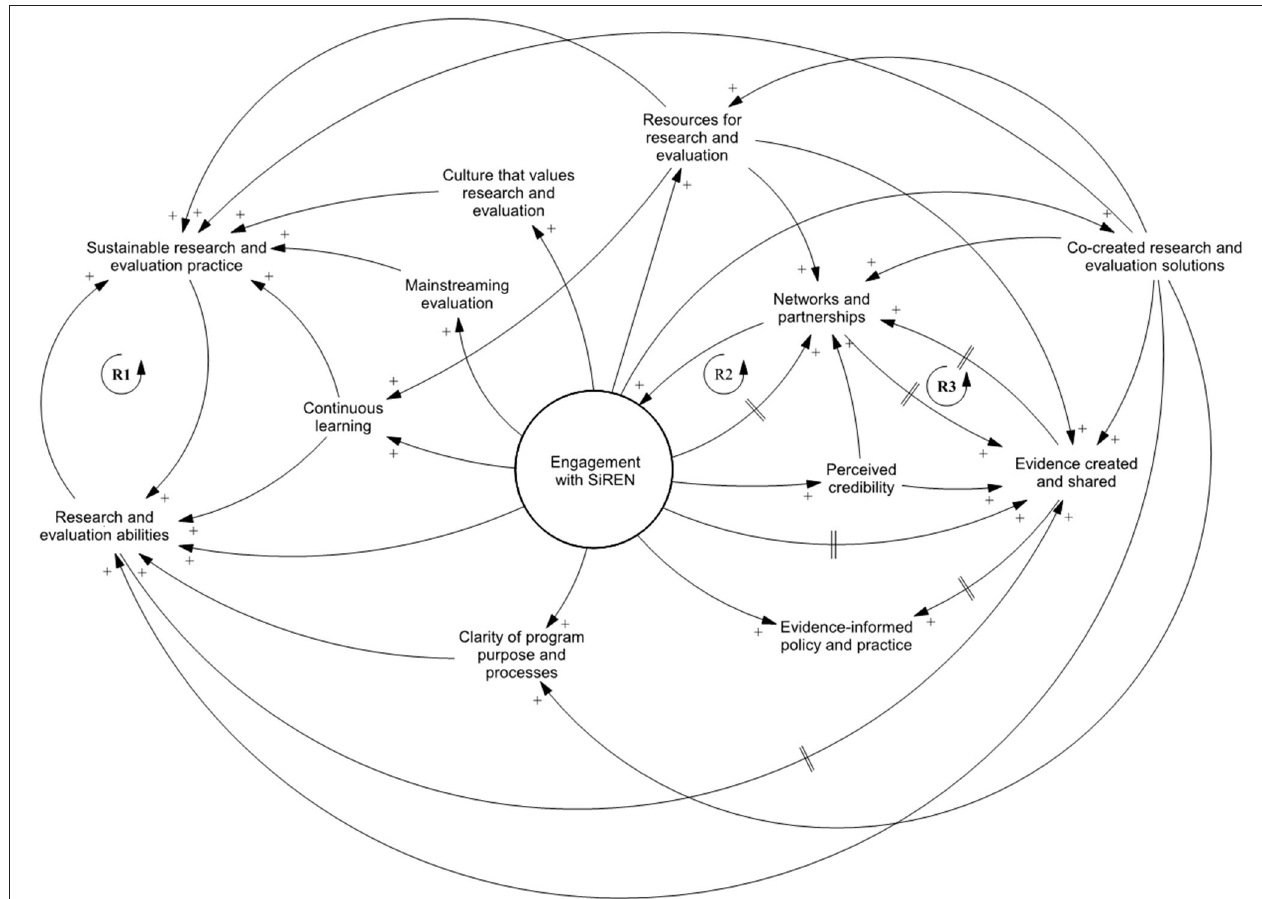
FIGURE 2 | Causal loop diagram of impacts and